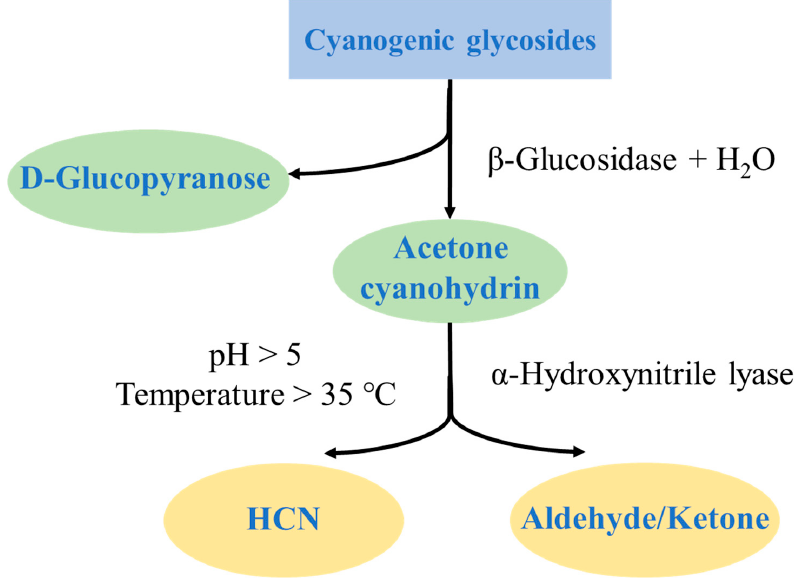
Figure 2. Degradation pathway of cyanogenic glycosides (CGs) [32,33]. HCN, hydrocyanic acid.